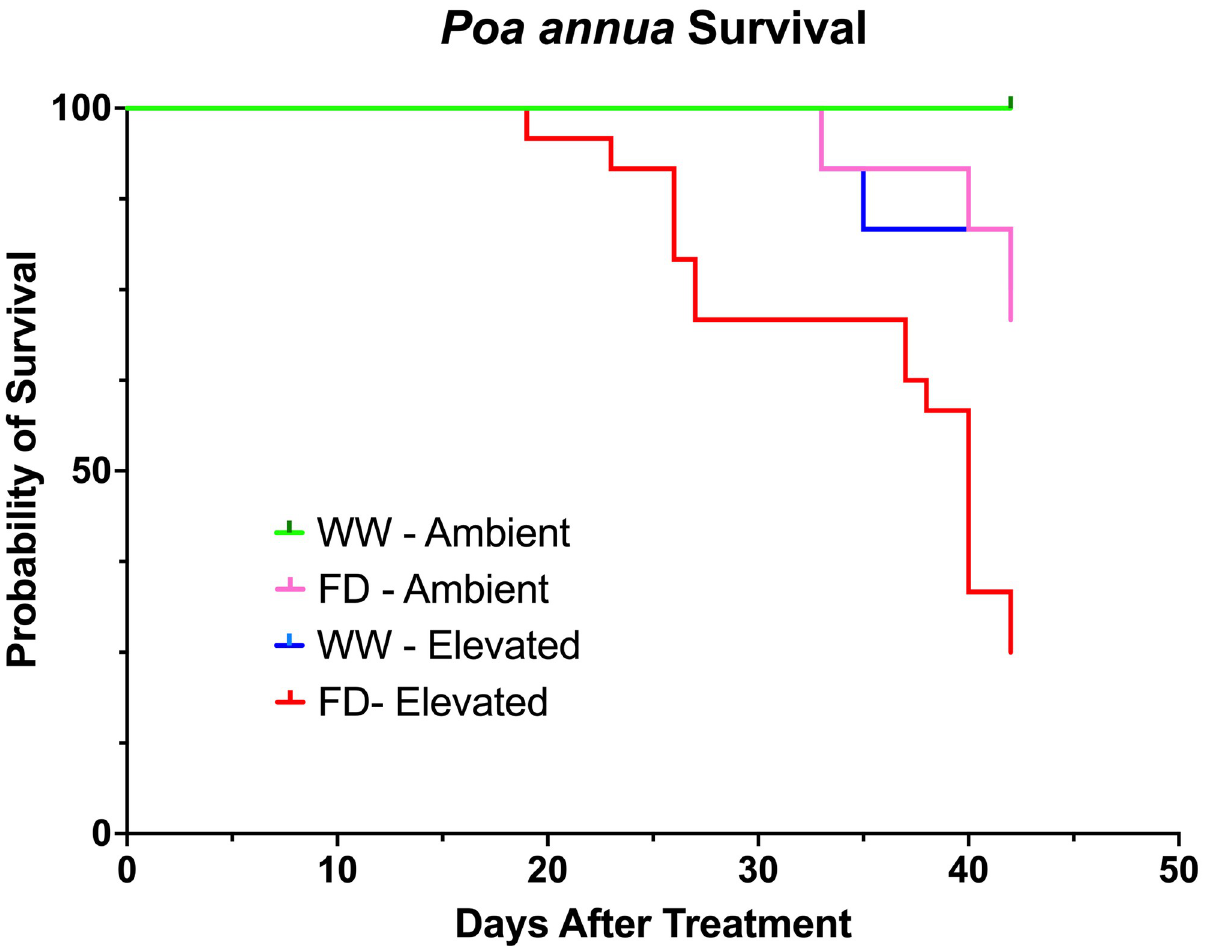
Fig 6. Plot of survival probabilities for Poa annua plants maintained at ambient or elevated soil temperatures and subjected to either well- watered or full drought conditions for 42 days. Probabilities were generated using the Kaplan-Meier estimate of survival function in Prism.